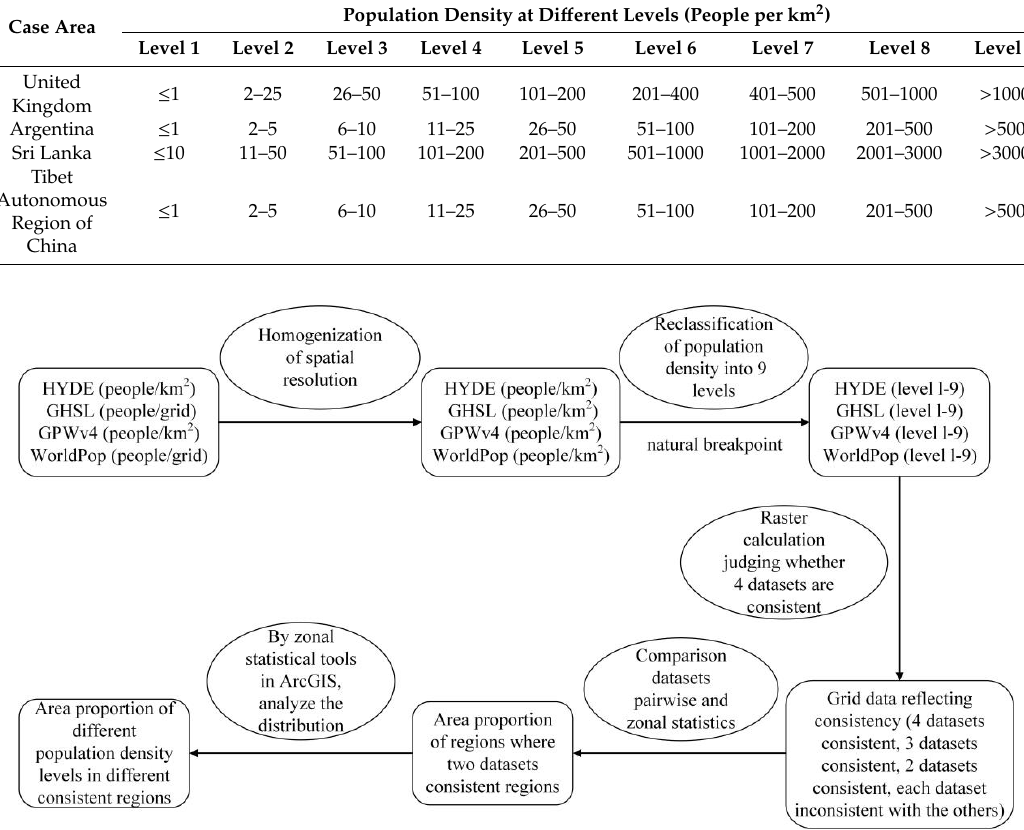
Figure 1. Process of consistency analysis.